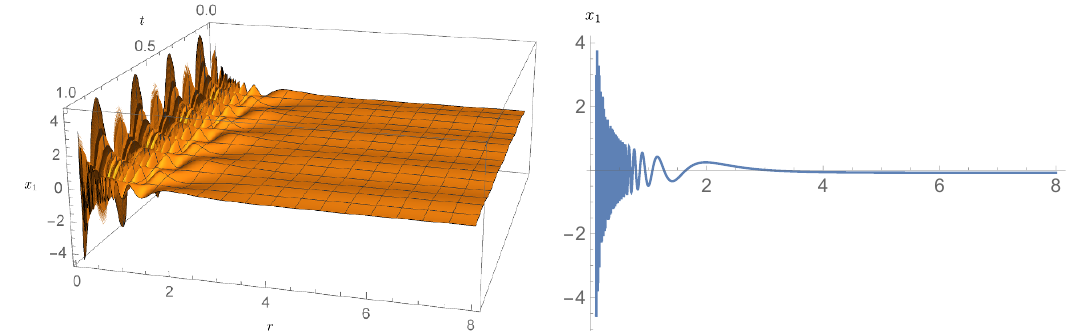
Figure 1 . The real part of the time dependent (cid:13)uctuations x 1 ( t; r ) = e (cid:0) i!t h ! ( r ) for a (cid:12)xed fre- quency and scalings of the background (taken as Lifshitz for the plot). Notice the large magnitude and density of excitations in the deep IR-small r , which result to the corresponding Brownian motion on the boundary-large r .